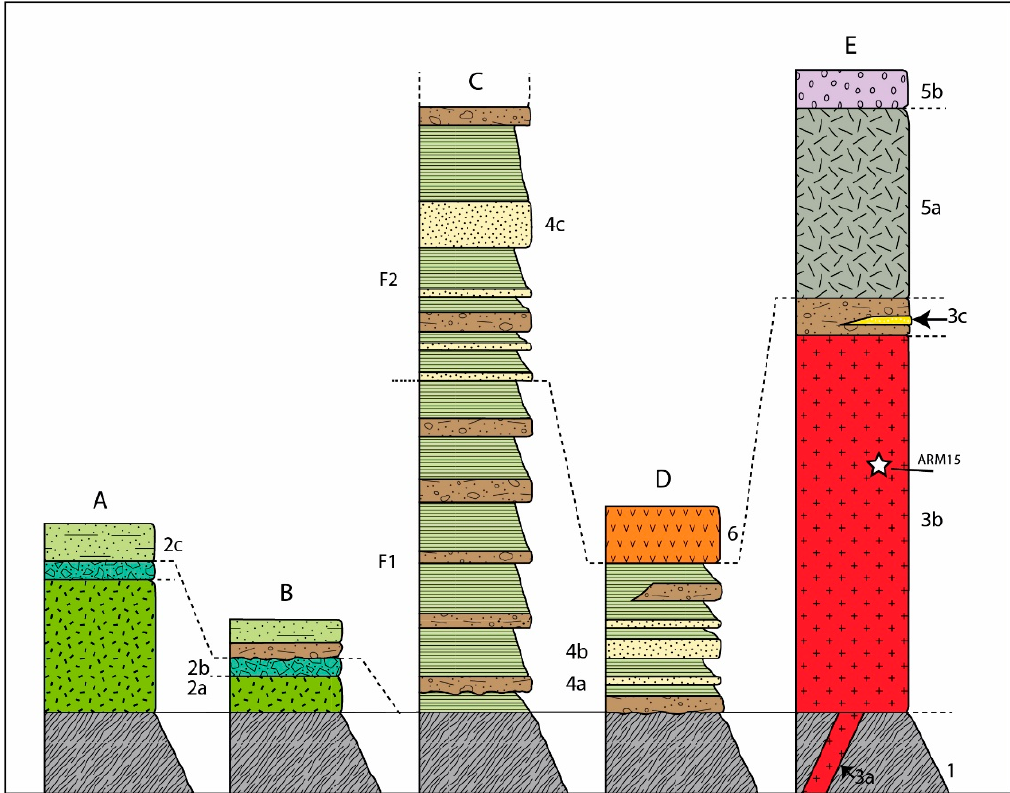
Figure 4. Lithostratigraphic columns of the Permian volcanic complex of TSESDAI: 1. Upper Visean Paleozoic terrains; 2. Tiddas pyroxene andesites in flows (2a), flow breccias (2b), and lapilli tuff and ash deposits (2c); 3. biotite rhyolitic dikes (3a), domes (3b), and lapilli tuffs and ash deposits (3c); 4. detrital formations of Permian conglomerates (4a), argillites (4b), and sandstones (4c); 5. Bled Bou Haouza dacites with pyroxenes (in flows (5a) and flow breccias (5b); 6A Sebt Ait Ikko andesites with olivine and pyroxenes. F1, lower formation; F2, intermediate formation. Location of sections; ( A ), west of Tiddas (Glimis); ( B ), west–southwest of Tiddas (KiKene); ( C ), northeast of Tiddas; ( D ), southwest of Sebt Ait Ikko; ( E ), south of Sebt Ait Ikko.